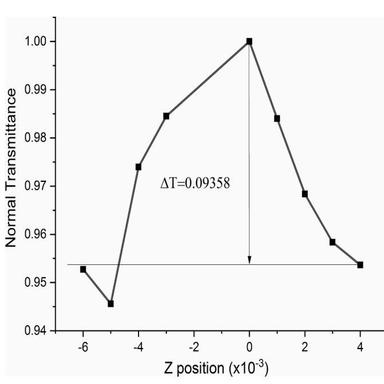
OPEN APERTURE MODE Z-SCAN PLOT